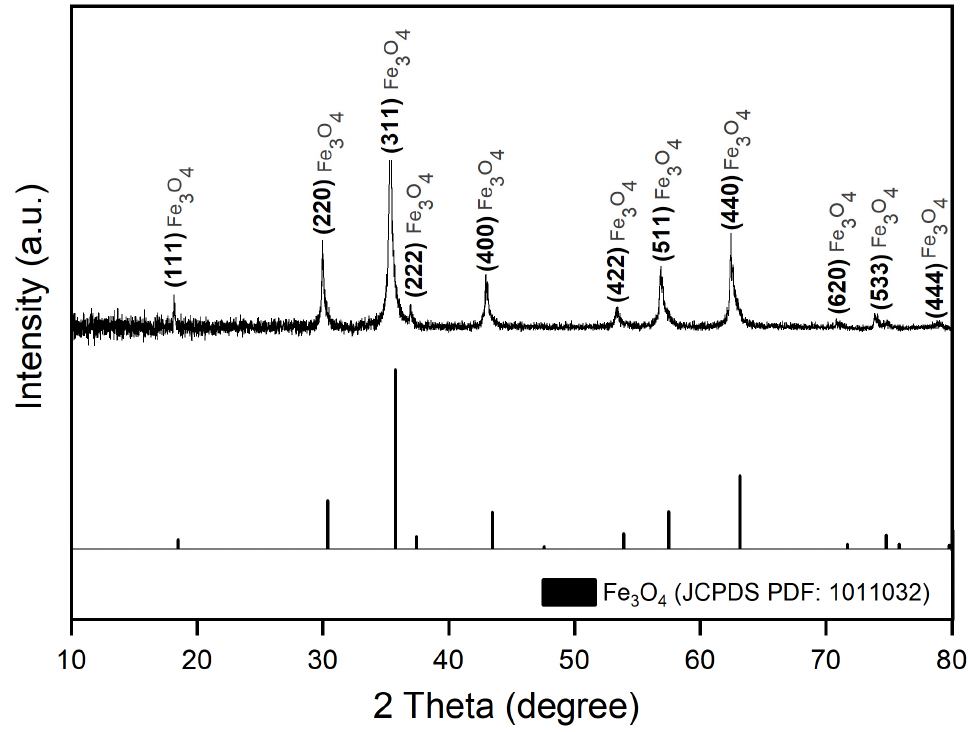
Figure 1. XRD pattern of magnetic nanoparticles, compared to the XRD patterns of magnetite, from the International Centre for Diffraction Data Powder Diffraction File (ICDD PDF) 4+ 2019